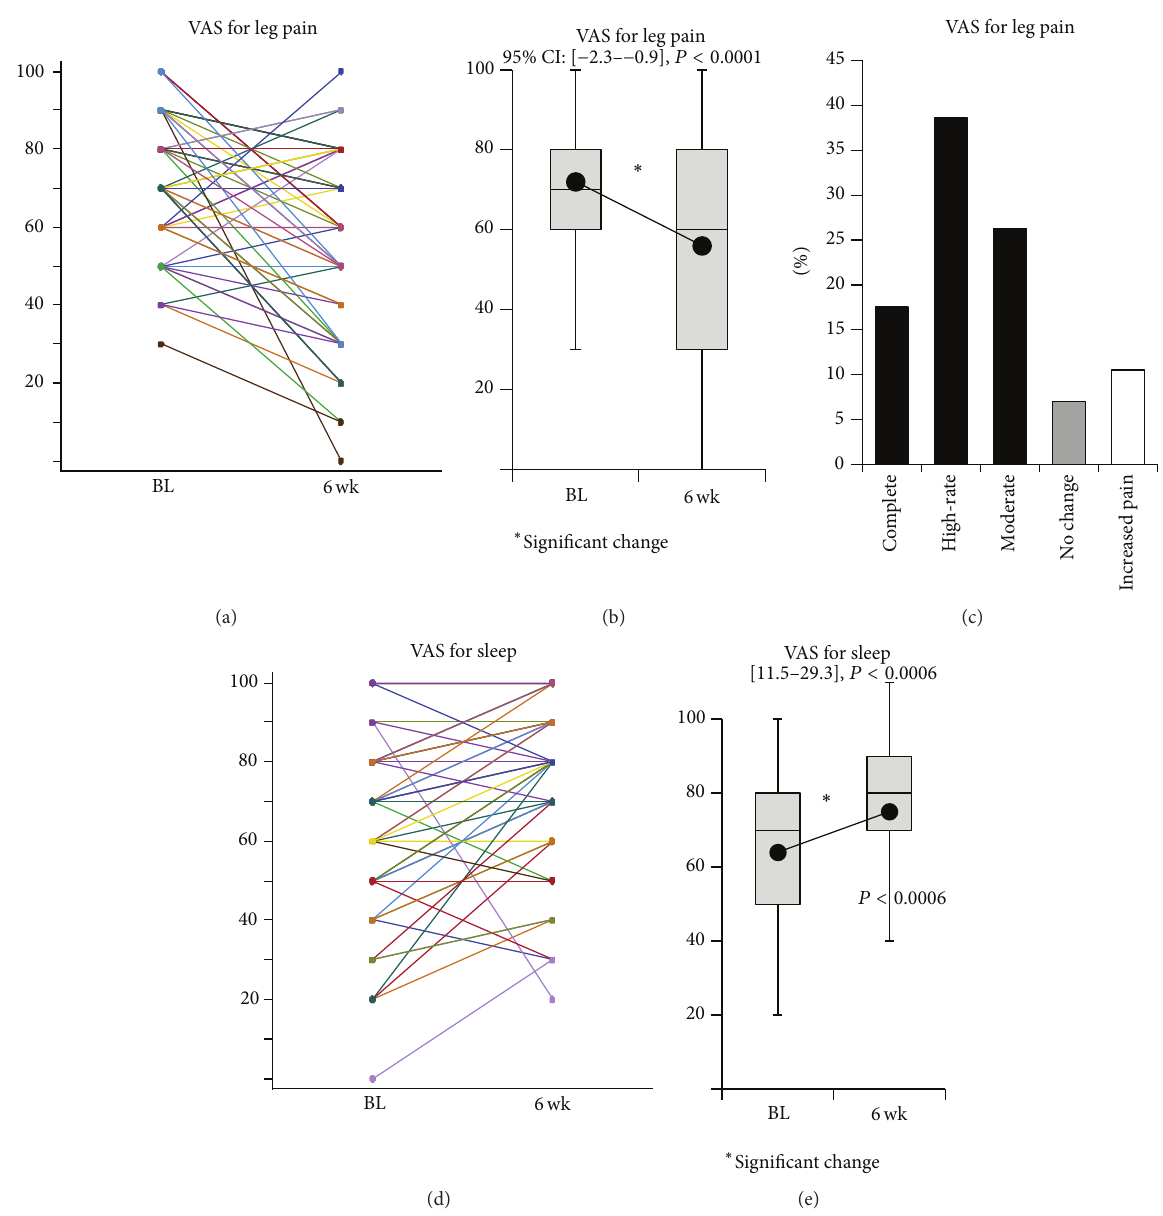
Figure 3: Visual analog scale (VAS) scores. (a, b, and c) Leg pain; raw data, followed by box and whisker plot. (d, e) Sleep quality; box and whisker plot. The average score at each time point is connected to indicate the tendency for change. Both scores are significantly decreased after the 6-week administration of pregabalin